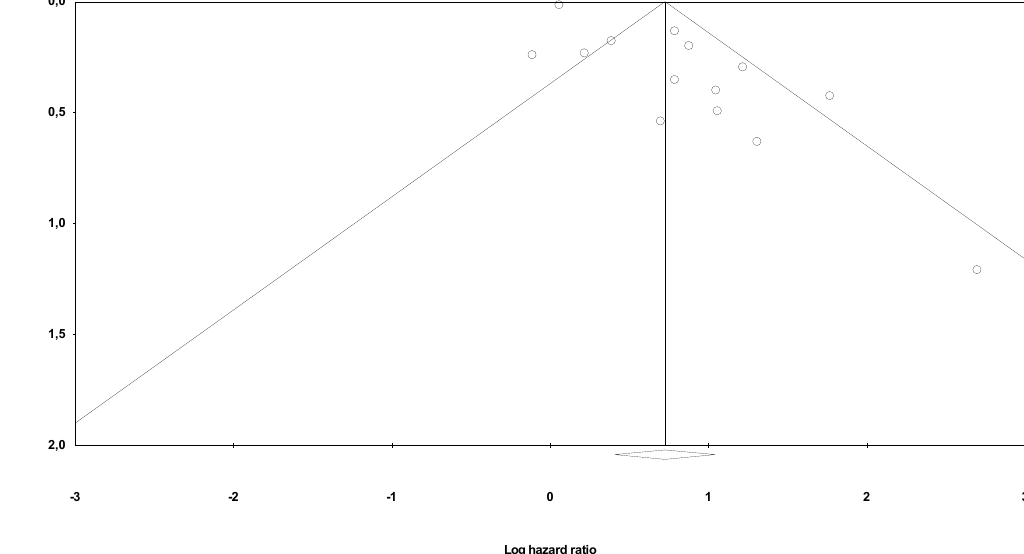
Figure 4. Funnel plot for publication bias (OS).